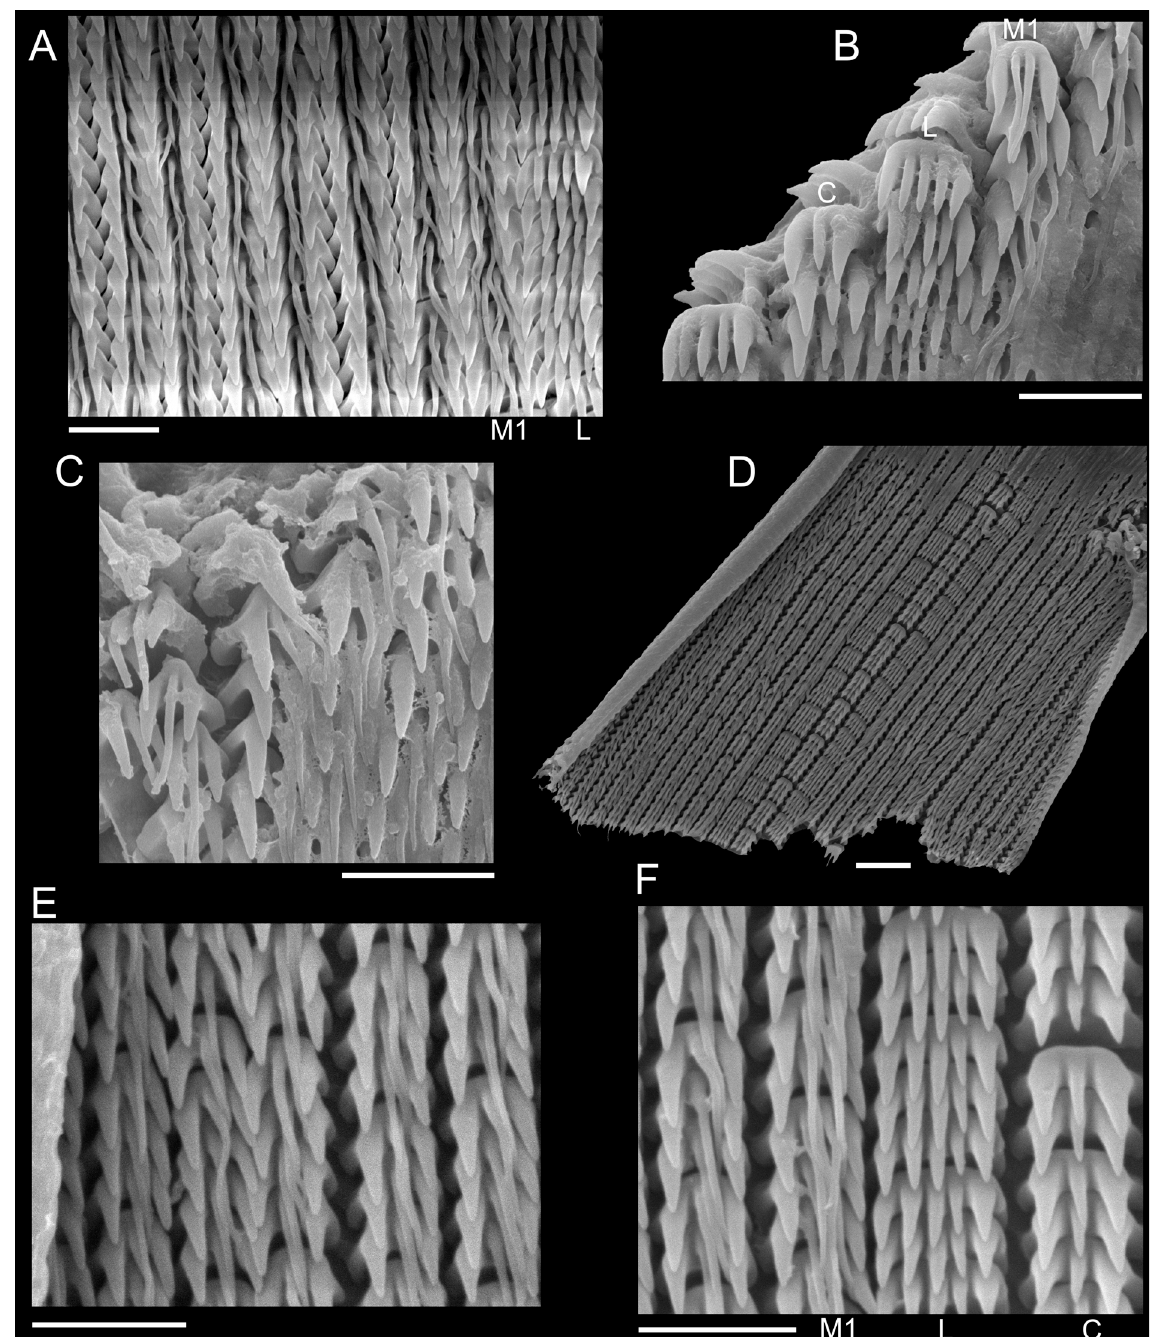
Fig. 23. Nototriphora decorata (C.B. Adams, 1850), radula. A . MNRJ 28854. B–C . ZUEC-GAS 1804. D–F . MNRJ 32763. Scale bars: A–C, E–F = 5 µm; D = 10